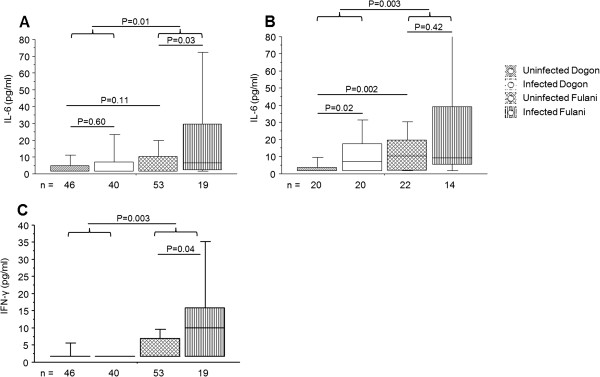
Cytokine levels in plasma from Dogon and Fulani individuals. Blood plasma samples from 158 individuals were analysed for levels of IL-6 and IFN-γ. Individuals were divided according to ethnicity and infection status. Levels are shown for A and C) the total population and B) the children cohort from 2008 (aged two to ten years). The boxes represent the lower quartile (25%) and the upper quartile (75%) with the middle line as the median. The whiskers indicate the 10 and 90% percentiles. Statistical analysis was done with Kruskal-Wallis and Mann–Whitney U test.